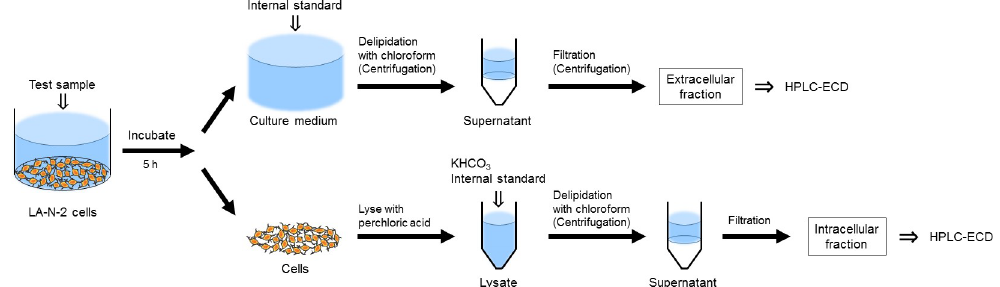
Fig 1. A schematic diagram of the new in vitro assay system. The procedures to measure extracellular and intracellular acetylcholine levels are illustrated.